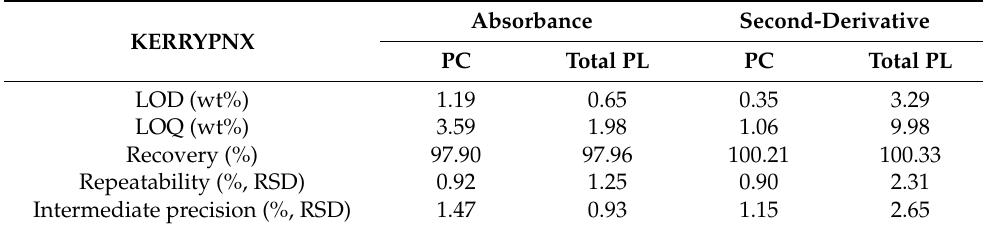
Table 2. LOD, LOQ, recovery, repeatability, and intermediate precision of FT-IR method. Absorbance KERRYPNX